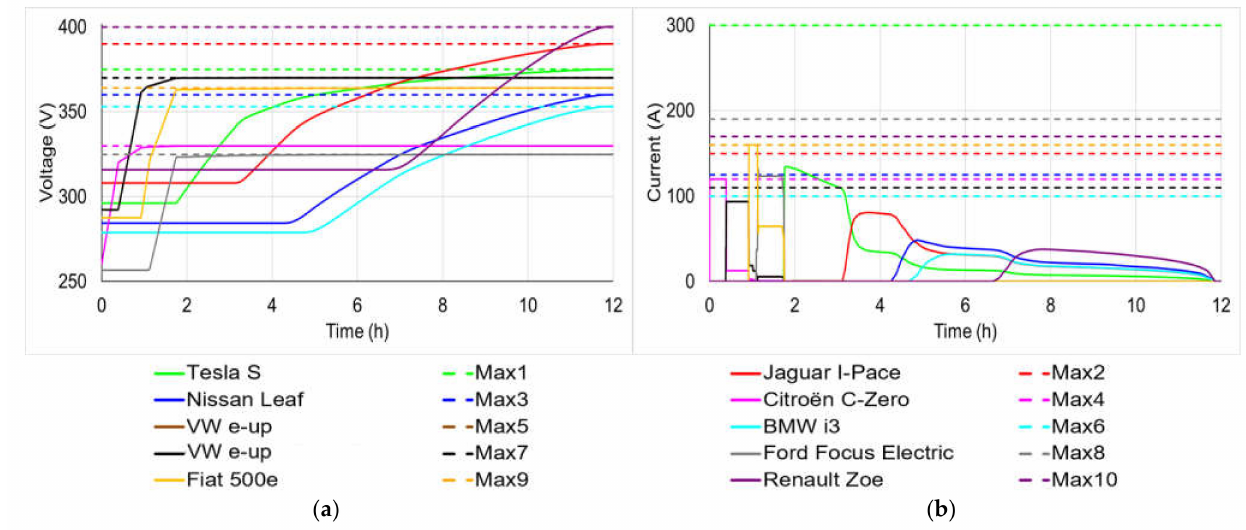
Figure 8. Battery terminal voltage ( a ) and current ( b ) of the EVs during charging for the fourth scenario.